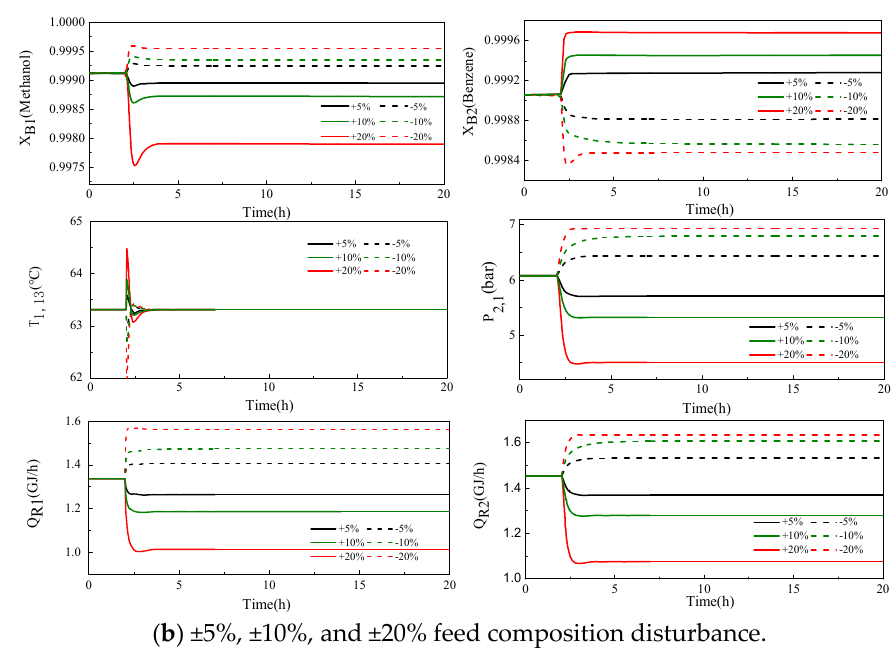
Figure 13. The dynamic responses of control structure CS2.